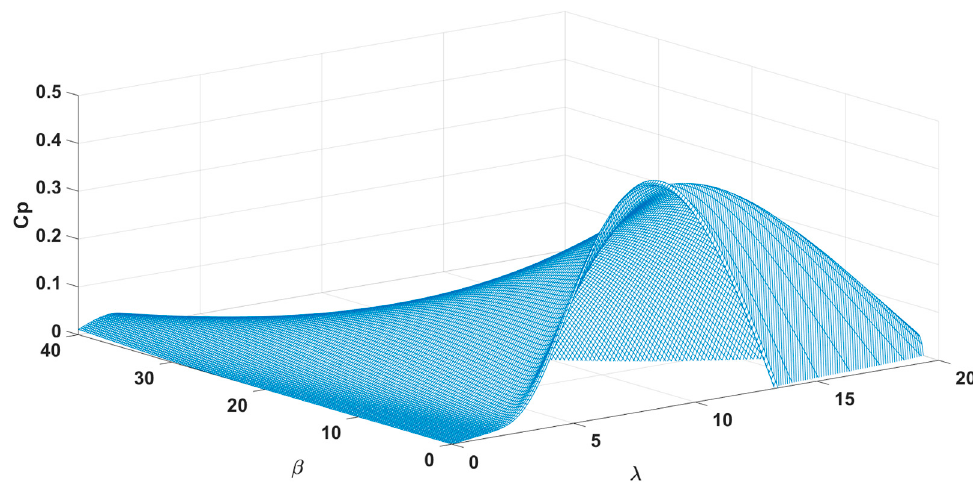
Figure 3. The aerodynamic power coefficient for 5-MW VSWT.